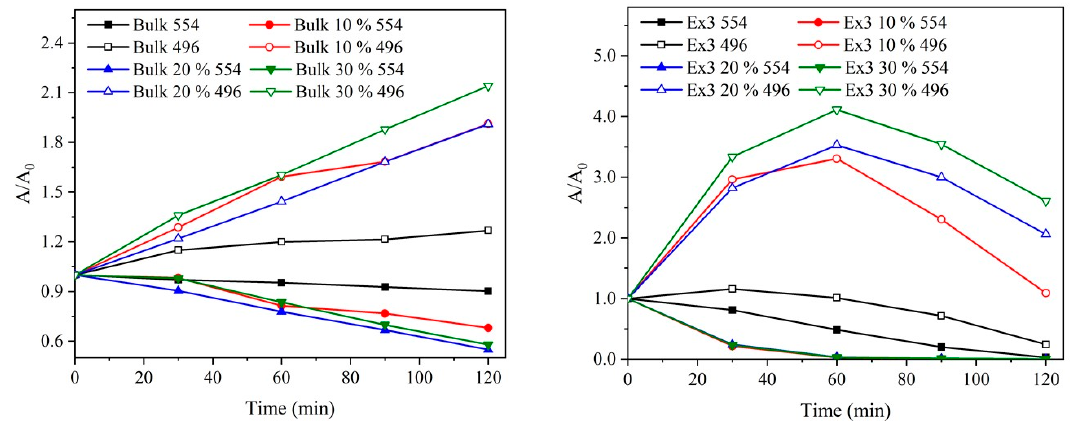
Figure 13. Photocatalytic degradation of RhB in suspensions of bulk ( left ) and selected exfoliated GCN nanomaterials ( right ).